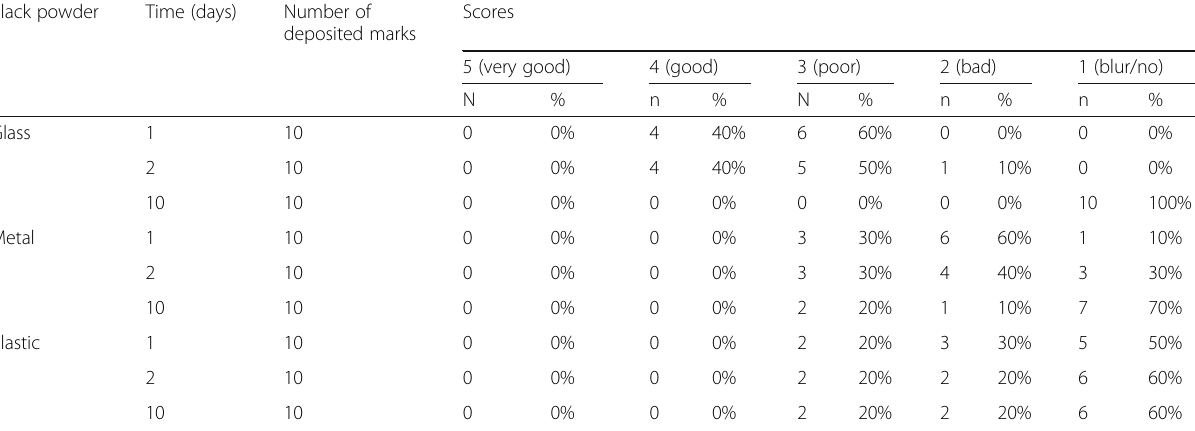
Table 1 Fingerprints development scores using black powder technique on glass, metal and plastic surfaces submerged in sea water at 1, 2 and 10 days ’ intervals according to fingerprints quality assessment scale Black powder